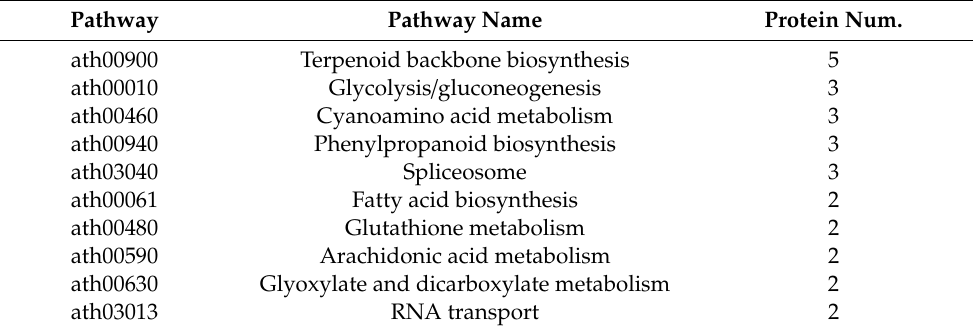
Figure 4. Gene ontology classification of the di ff erential proteins identified based on Arabidopsis thaliana database. Table 2. The 10 KEGG pathways annotated by major di ff erential proteins.